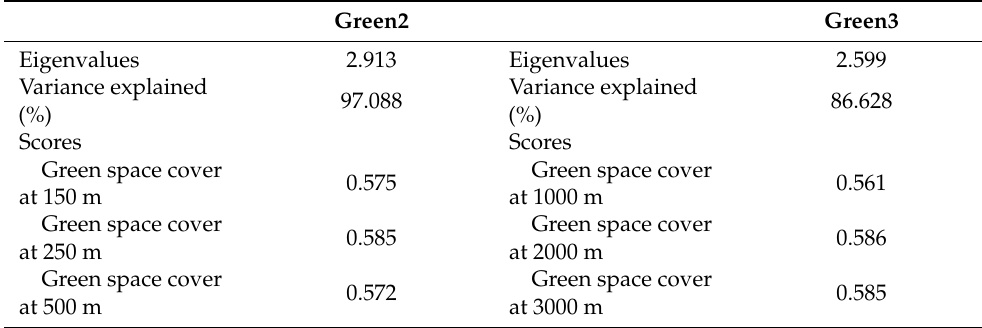
Table A2. Results of PCA performed for the green space cover variables at different spatial scales used to analyse butterfly community response to urban environment. Only components with eigenvalues >1 are shown here. Green2 is the PCA axis explaining the highest variation in the proportion of green space cover with 150 m, 250 m, 500 m from the park boundary. Green3 is the most explained PCA axe axis explaining the highest variation in of the proportion of green space cover with 1000 m, 2000 m, 3000 m from the park boundary.